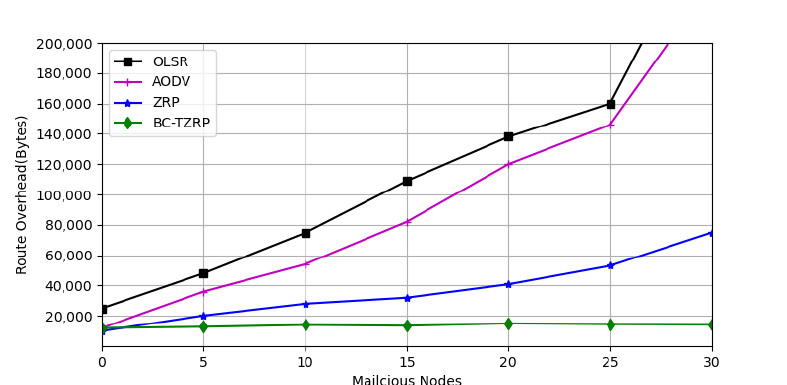
Figure 5. Routing overhead for the case of progressively increasing fault nodes. The average end-to-end delay refers to the time elapsed from the time the packet leaves the source node until the packet arrives at the destination node. As can be seen in Figure 6, in the absence of error nodes ZRP has the lowest latency, OLSR is at the low end and AODV has a higher latency, again due to interference from error nodes, the average end-to-end latency of all three rises rapidly and when error nodes exceed 25, the network system is in a state of collapse and the latency tends to infinity. BC_TRZP maintains the actual trustworthiness of the network performing the task, and by completing inter-zone routing through the upper layers of the network consisting of the regional centers, the average end-to-end delay was kept at a small